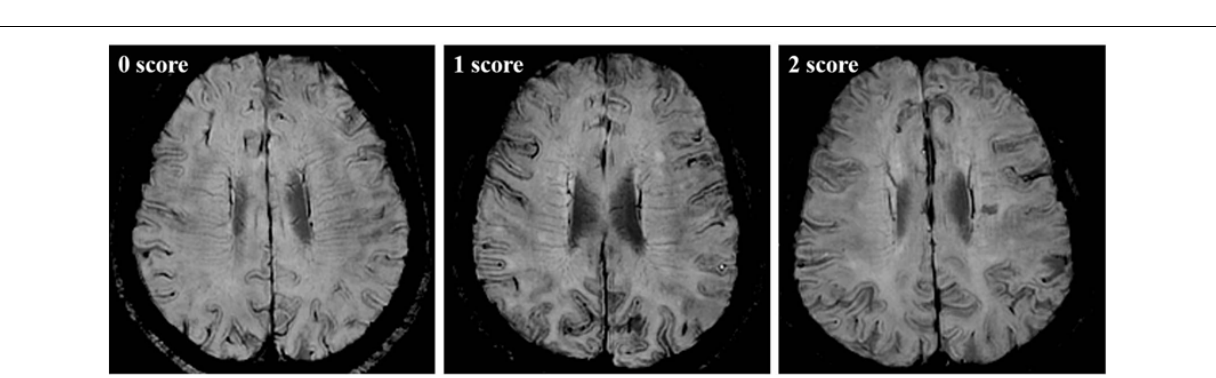
FIGURE 1 | Demonstration of processing pipelines and ROI placement. The locations of ROIs were confirmed on both diffusion and susceptibility images. White crosshairs indicate ROIs in bilateral association fibers. Yellow crosshairs indicate ROIs in bilateral projection fibers.